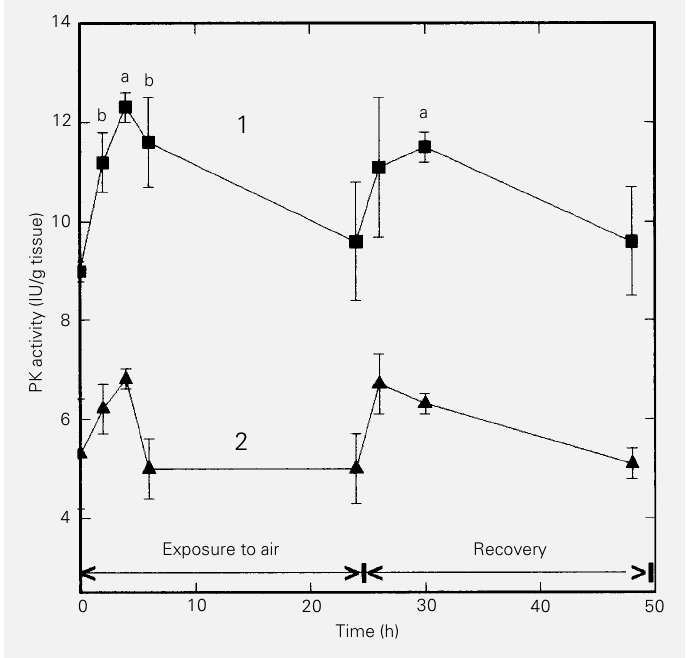
Figure 1 - Effect of exposure to air and recovery on pyruvate kinase (PK) activity measured at saturating substrate concentrations (1 mM phosphoenolpyruvate and 2 mM ADP, curve 1) and low phosphoenolpyruvate concentration (0.15 mM, curve 2). Data are reported as means – SEM for four individuals. Significantly different from (cid:147)zero(cid:148) time with a P<0.001 and b P<0.025.